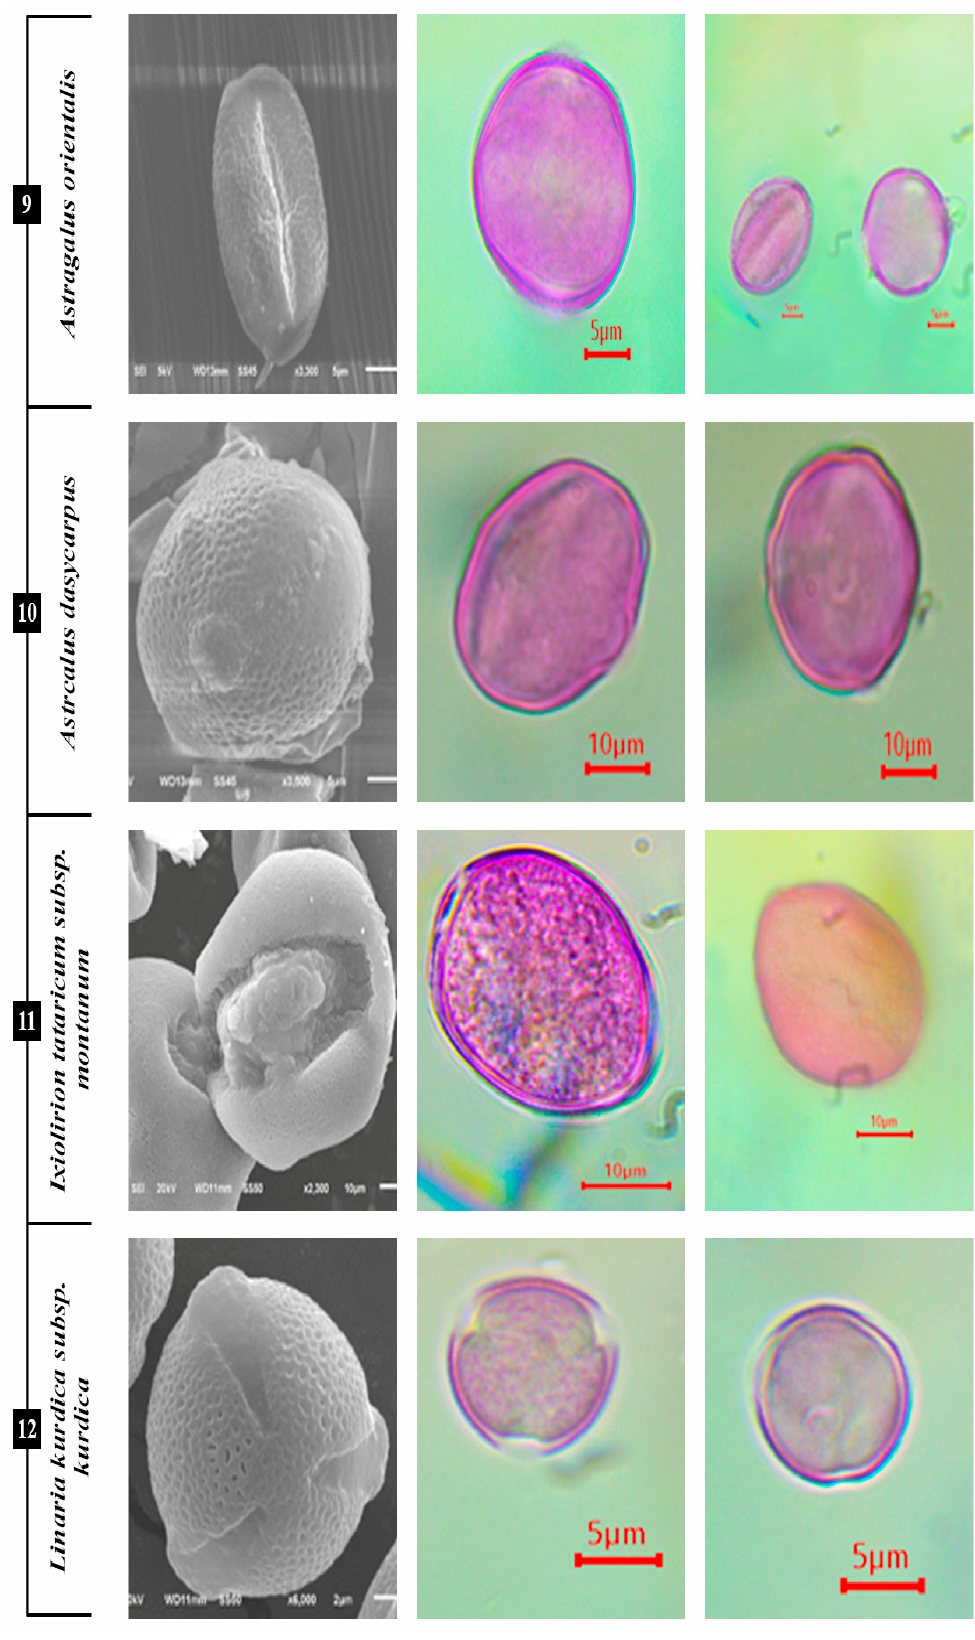
Figure 5. Scanning and light microscopic images of A. orientalis , A. dasycarpus , I. tataricum subsp. montanum , and L. kurdica subsp. kurdica ,